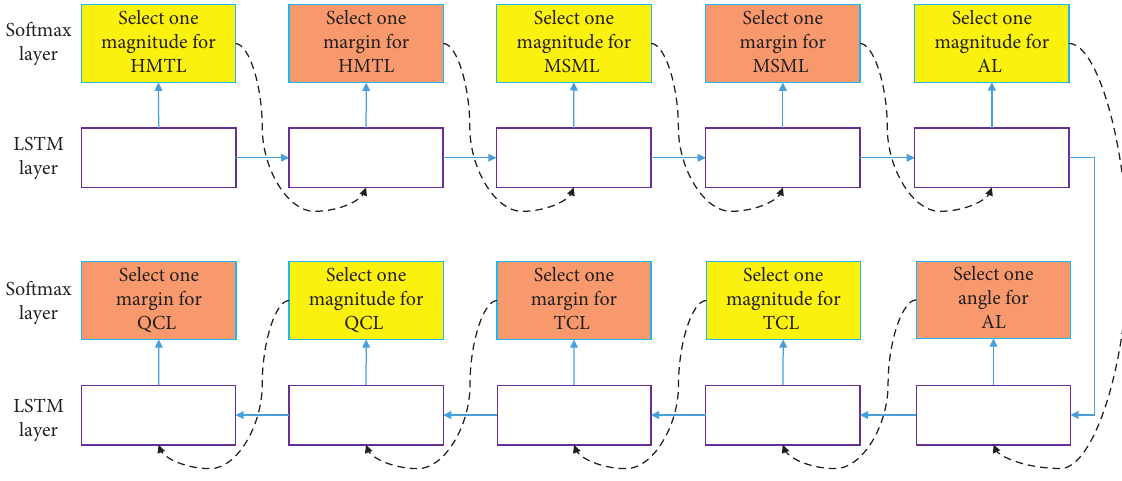
Figure 4: Recursively constructing loss architectures by the